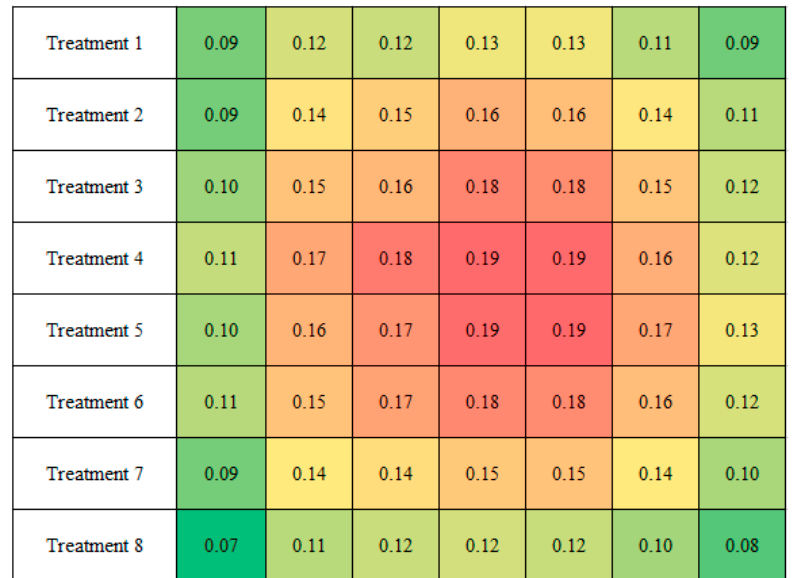
Figure A5. Map of UV light intensity (irradiance) measurements for UV − C (254 nm) for Treatment 1 to Treatment 8. Each colored grid represents an approximately ~4 × 4 cm area where the UV sensor was in place for measurement. The color gradient green − yellow − red represents increasing UV light intensity. Units: mW/cm 2 .